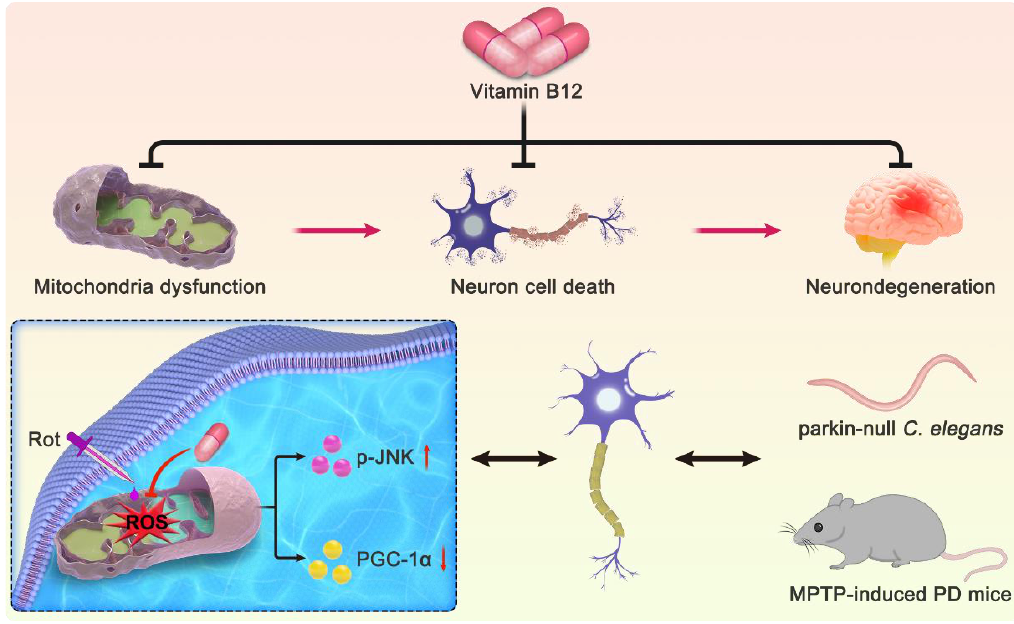
Figure 7. VB12 effectively alleviated the symptoms of PD models in vitro and in vivo.